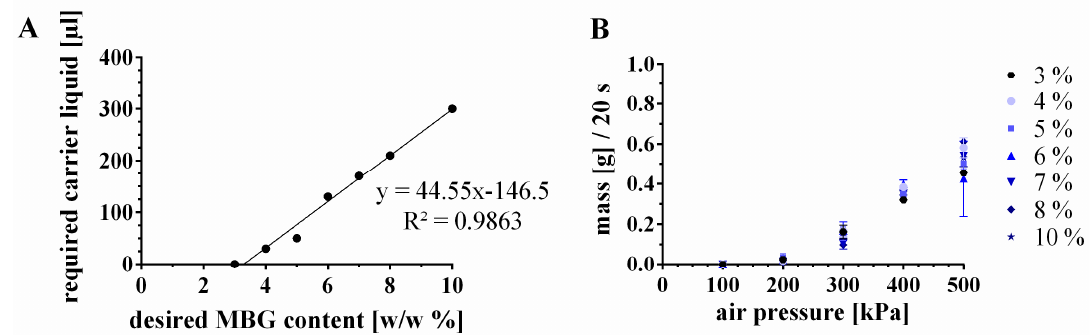
Figure 3. Adjustment of pasty CPC to incorporate MBG particles without impairing the mass flow through a 610 µm needle. ( A ) The mass flow of a 3%-MBG-CPC paste was the blueprint for the mass flows of MBG-CPC composites with higher MBG amounts. The mass flow was adjusted by addition of carrier liquid to the pasty CPC (see Table 1 for the final compositions). ( B ) Extrusion profiles of di ff erently concentrated MBG-CPC pastes with adjusted carrier liquid concentration (mean ± standard deviation, n =